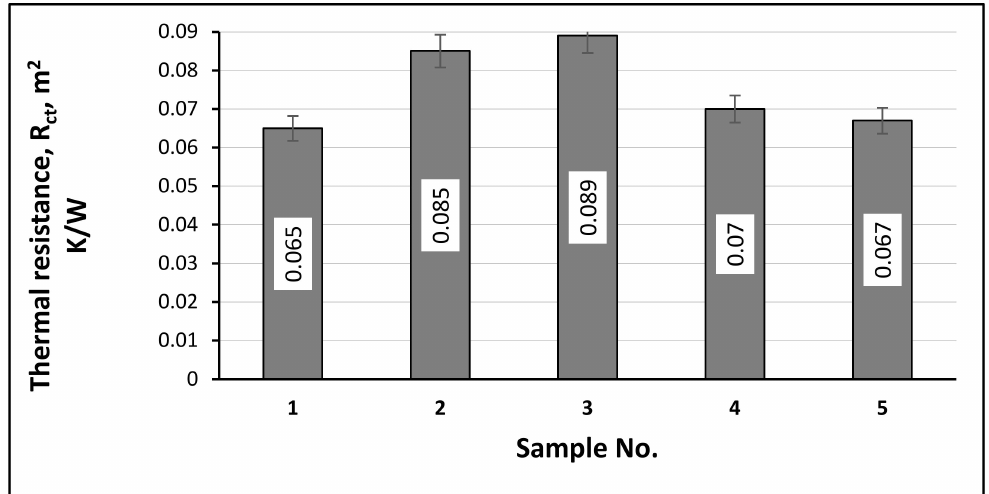
Figure 12. Thermal resistance of the different structures of